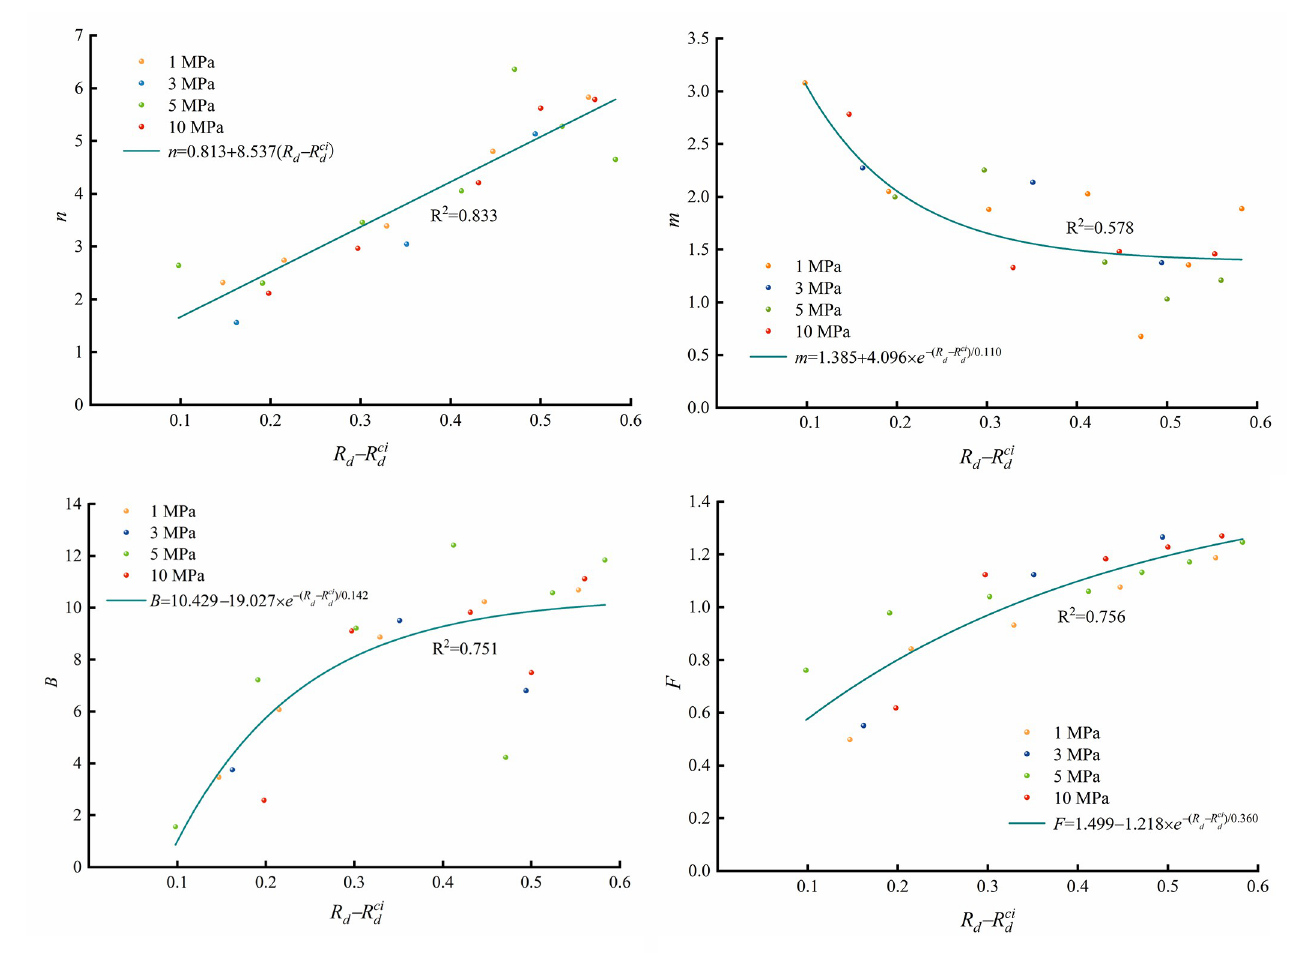
Fig 18. Creep crack element